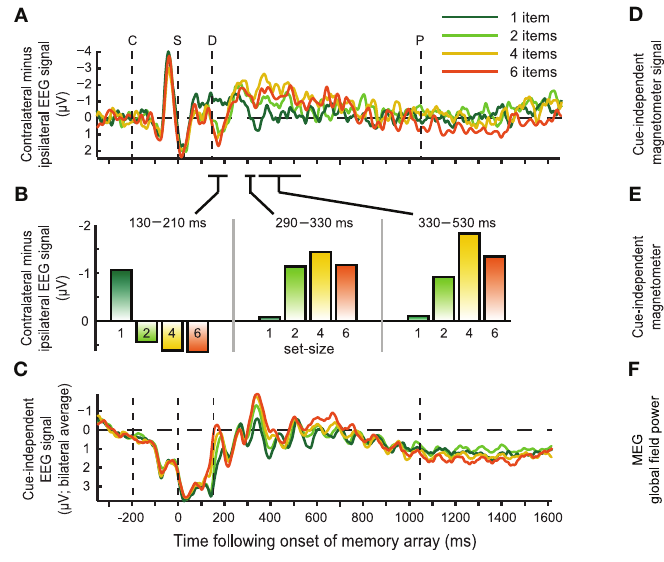
magnetometer topographies in the middle of the delay period (550 ms) for each set-size, averaged across cue directions; white dots indicate sensor locations and contours mark those sensors for which the time-course is plotted above; (F) Global field power across all MEG sensors. The onset of the cue, sample, delay, and earliest possible probe are marked by the dashed lines, labeled C, S, D, and P respectively.